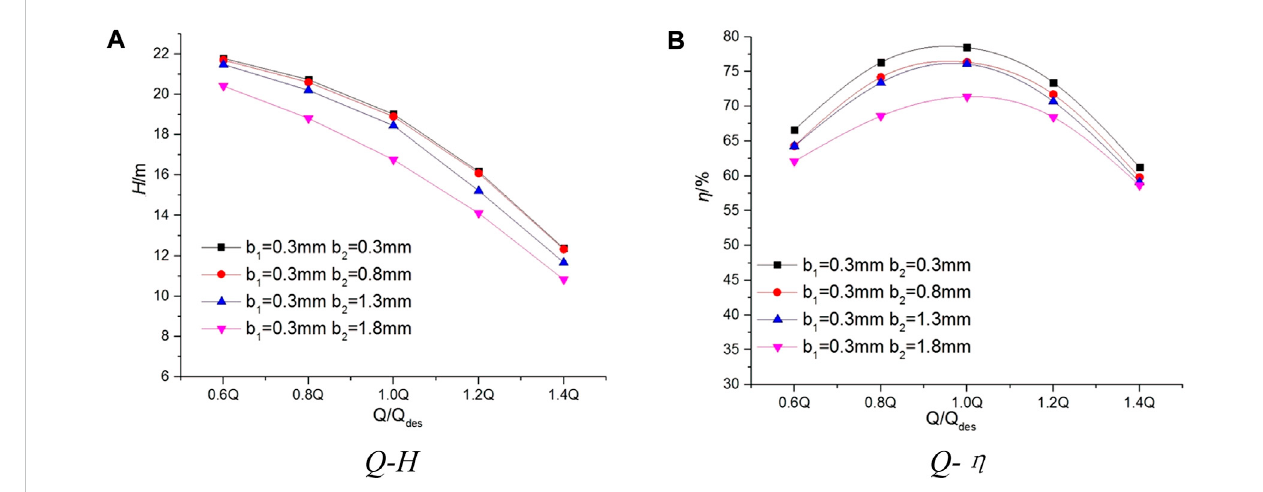
FIGURE 5 The performance curves of Scheme 2. (A) Q-H ; (B) Q- η